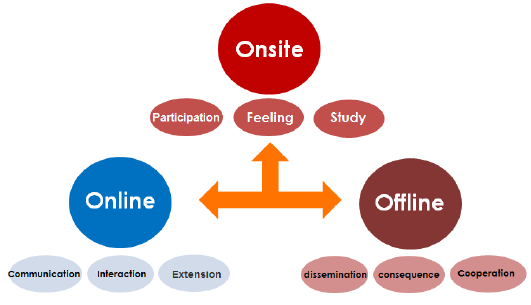
Figure 8: 3-O service model